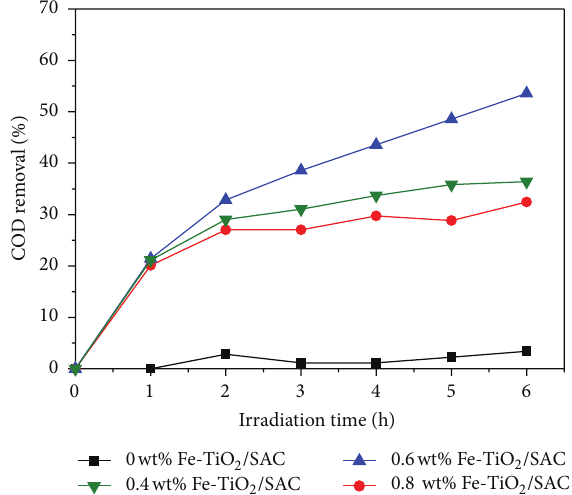
Figure 4: COD removal on the photocatalytic degradation of humic acid by Fe-TiO 2 /SAC under light irradiation with wavelength range of 315 ∼ 400